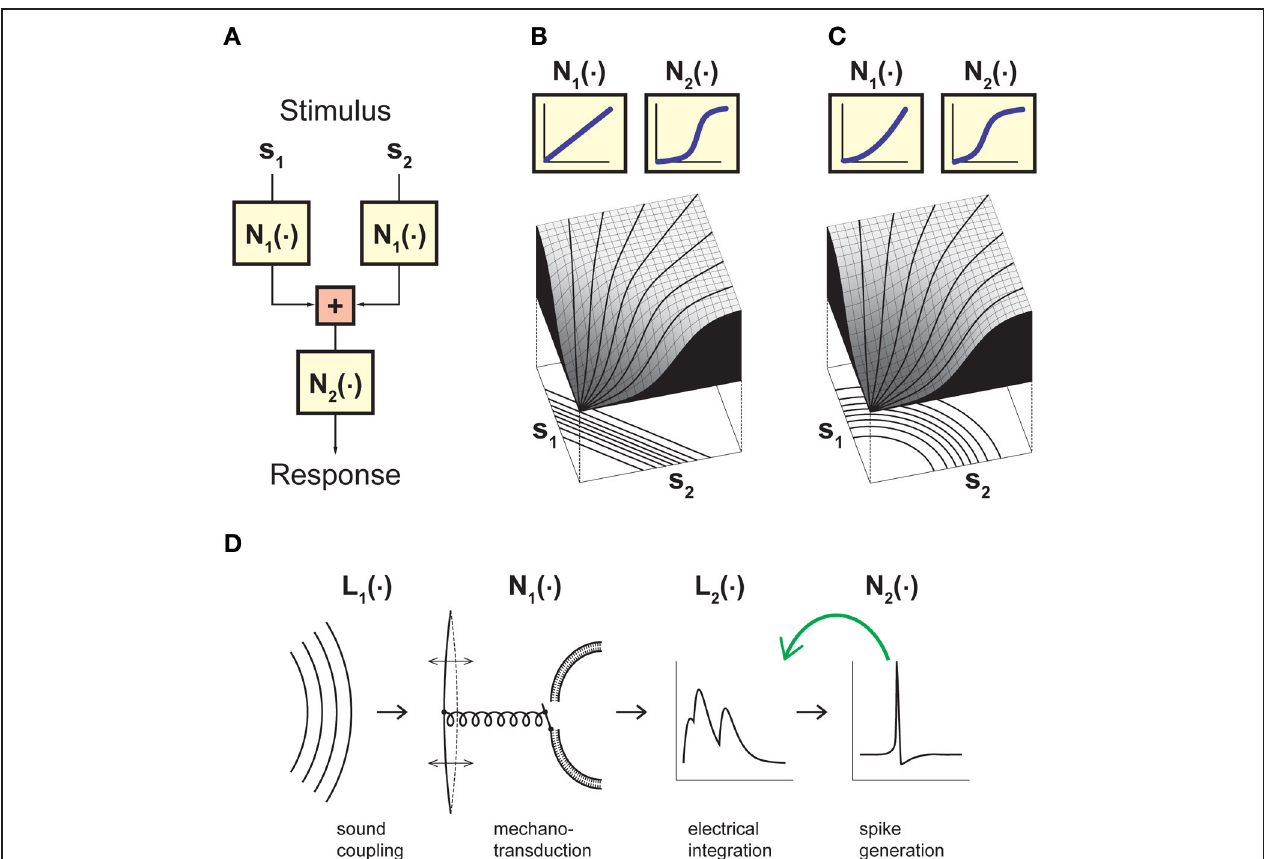
FIGURE 1 | Model framework for analyzing neuronal stimulus integration with iso-response measurements. (A) A canonical model for separating non-linear effects before and after stimulus integration. The model considers two (or more) separate inputs s 1 ... s n , which each undergo a non-linearity N 1 before summation, and a final output non-linearity N 2 . Stimulus integration is governed by the non-linearity N 1 , whereas N 2 provides a transformation of the integrated signal. Assessing the nature of stimulus integration thus amounts to measuring N 1 independently of N 2 . (B) Model responses obtained with linear stimulus integration and sigmoidal output transformation. The response surface is dominated by the sigmoidal shape of the output non-linearity, but the iso-response curves shown below the surface plot are straight lines and thus reveal the linear nature of stimulus integration in this model. (C) Same as (B) , but with a quadratic non-linearity